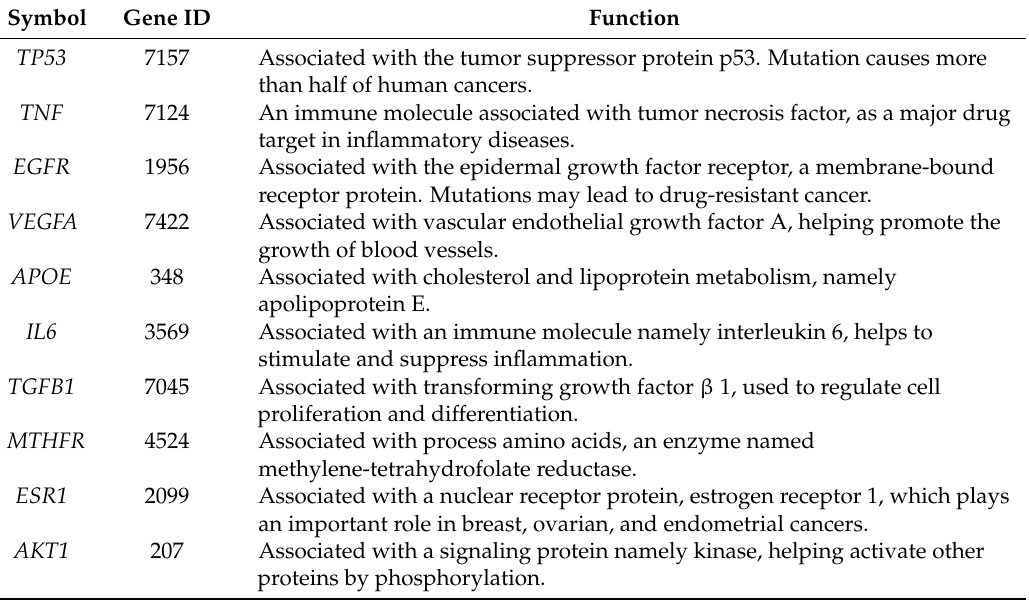
Table 1. The top-ten most popular